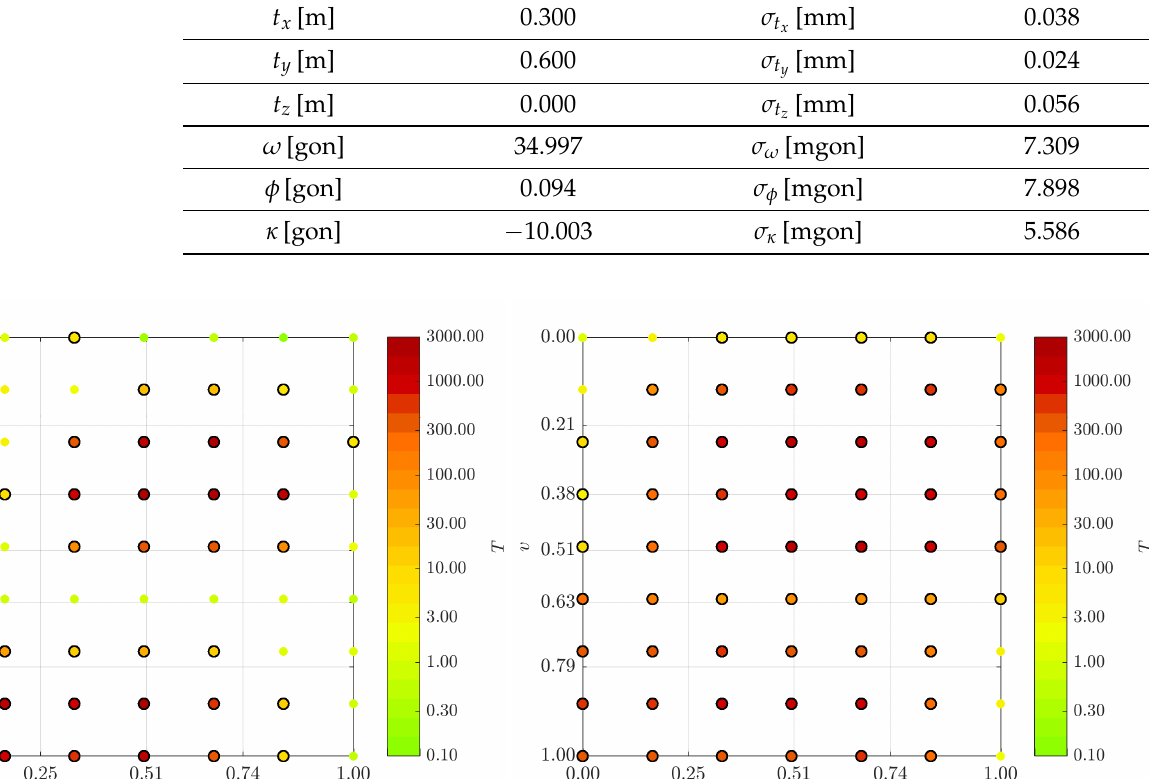
Table A5. Results of the estimated rigid body movement after having extended S CS (data set V18,